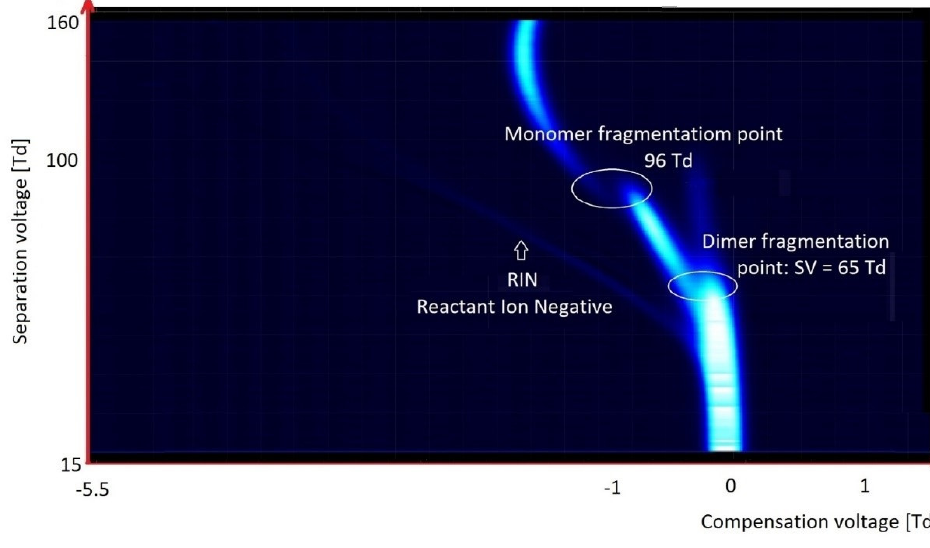
Figure 14. DMS spectrogram of phenol.